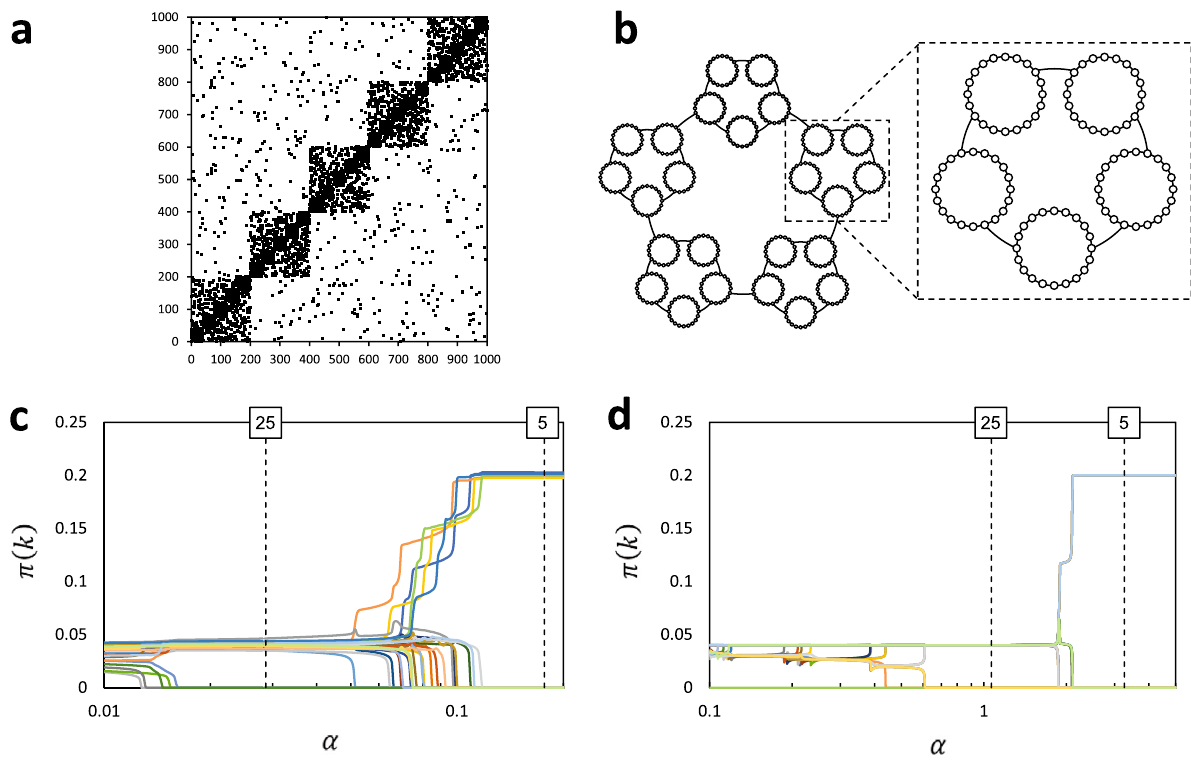
Figure 6. ( a ) The adjacency matrix of a block-of-blocks-of-blocks. ( b ) A network diagram of the ring-of- rings-of-rings. ( c , d ) The course of π( k ) ’s as quasi increase in α for the block-of-blocks-of-blocks ( c ) and the ring-of-rings-of-rings ( d ). Relatively stable phases, for which centre values for α are indicated by vertical dotted lines, characterize individual layers of hierarchy. A numeral attached to each dotted line indicates the number of non-vanishing π( k ) ’s, namely, the number of survived communities in the corresponding layer.